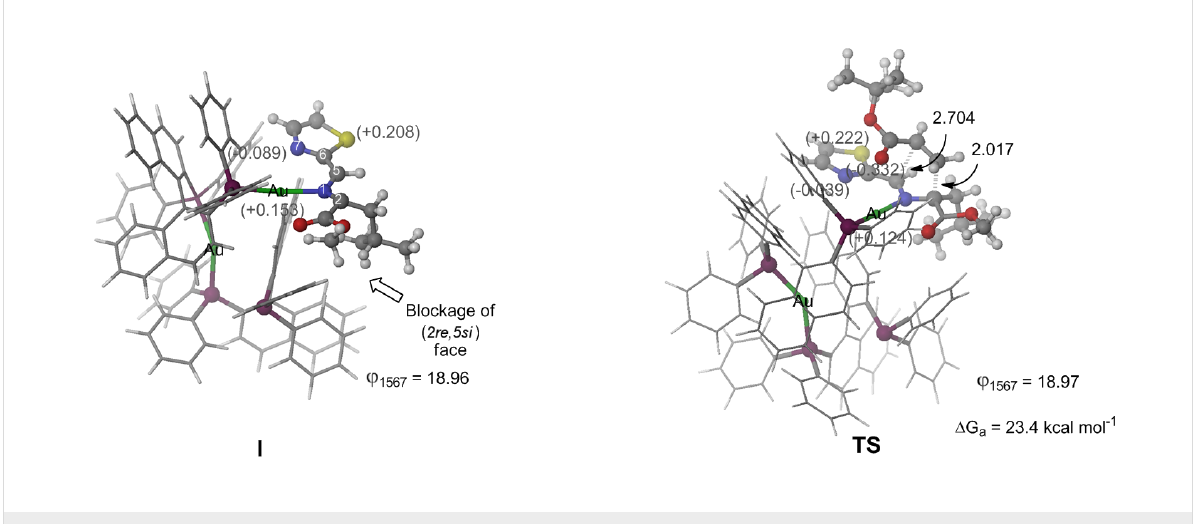
Figure 3: Gibbs activation energy and main geometrical features of the computed ylide and transition structures (TS) corresponding to the 1,3-DC of the Au(I)–ylide complex and tert -butyl acrylate computed at ONIOM(B3LYP/LanL2DZ:UFF) level of theory. High-level and low-level layers are repre- sented as ball & stick and wireframe models, respectively. Grey numbers in parentheses represent Mulliken charges. Distances are in